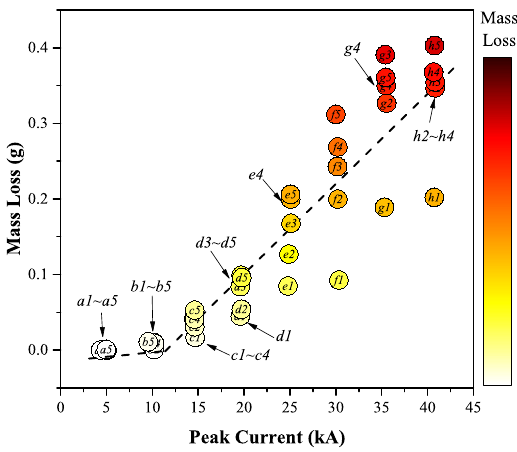
Figure 4. Measured mass loss of plug contact as a function of peak